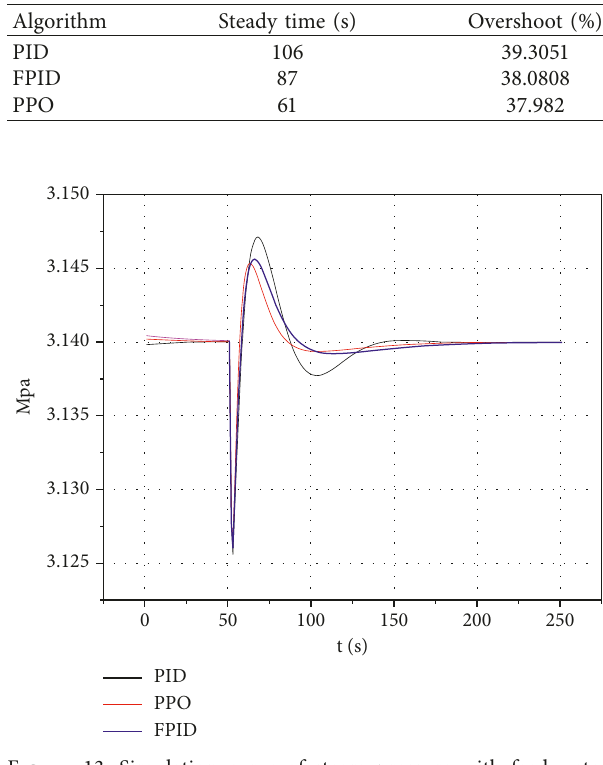
Figure 12: Simulation curve of steam pressure from 70%FP to 100%FP. Table 4: Performance indicators of the three algorithms when the load increases from 70% to 100%.